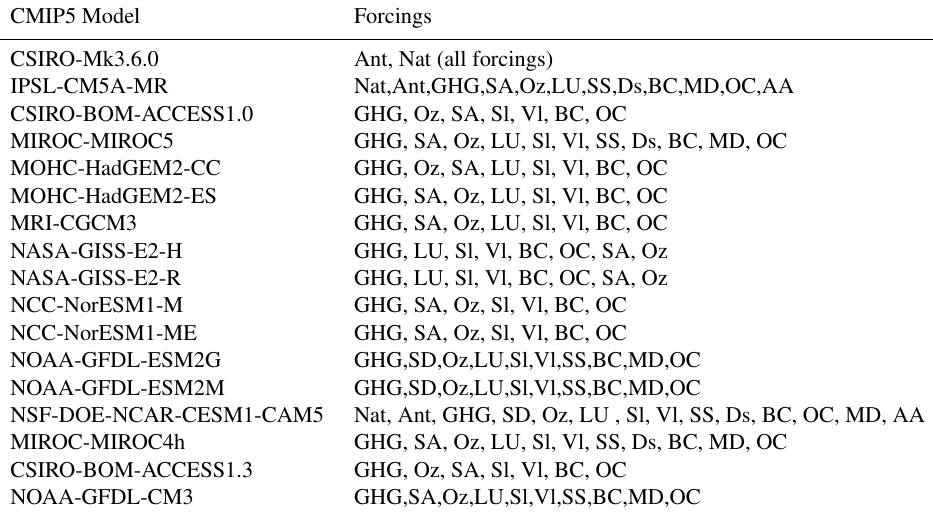
Table 1. Summary of forcings considered by the various models examined in this study. Ant = anthropogenic forcing, Nat = natural forcing, SD = anthropogenic sulphate aerosol (direct effect), SI = anthropogenic sulphate aerosol (indirect effect), GHG = well-mixed greenhouse gases, SA = SD + SI, SO = stratospheric ozone, TO = tropospheric ozone, Oz = TO + SO, Sl = solar irradiance, LU = land-use change, Vl = volcanic aerosol, Ds = Dust, OC = organic carbon, BC = black carbon, MD = mineral dust, SS = sea salt, AA = anthropogenic aerosols (CMIP5 data reference syntax document).